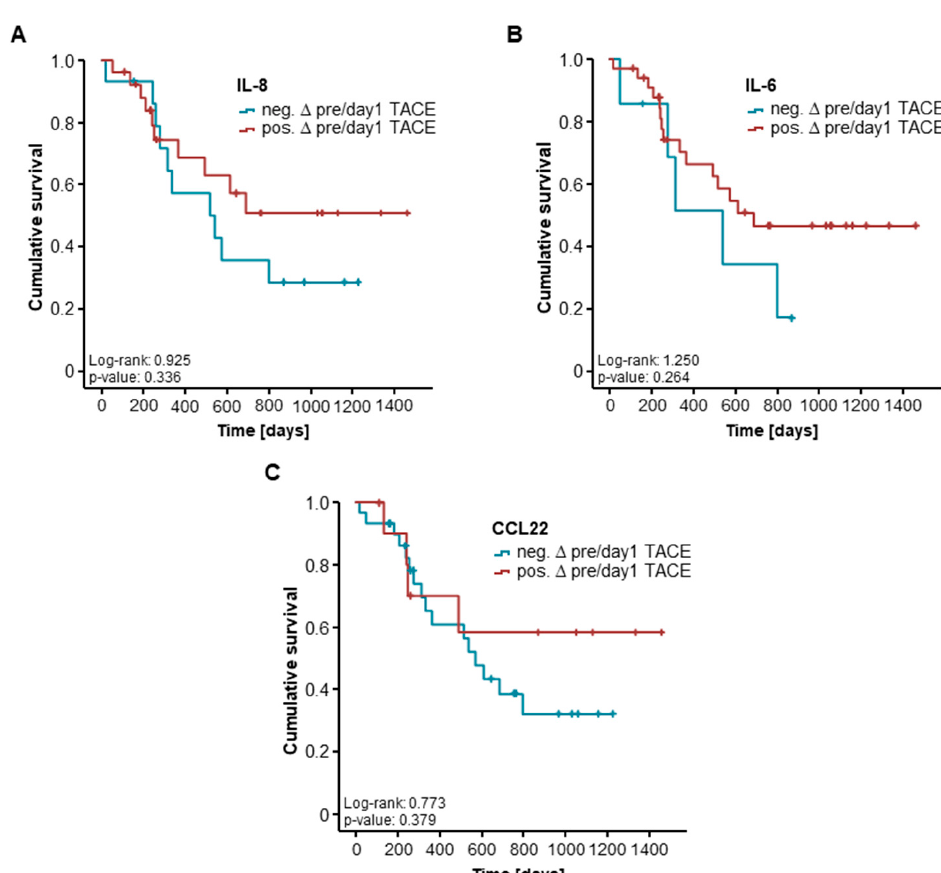
Figure 4. Longitudinal changes of cytokine serum levels and patients’ survival. ( A ) Longitudinal changes of IL-8 serum levels before and at day 1 after TACE are not associated with the patient’s survival after TACE therapy; ( B , C ) Patients who showed increasing levels of IL-6 and CCL22 at day 1 after TACE have a similar long-term survival compared to patients with decreasing post-interventional serum levels.